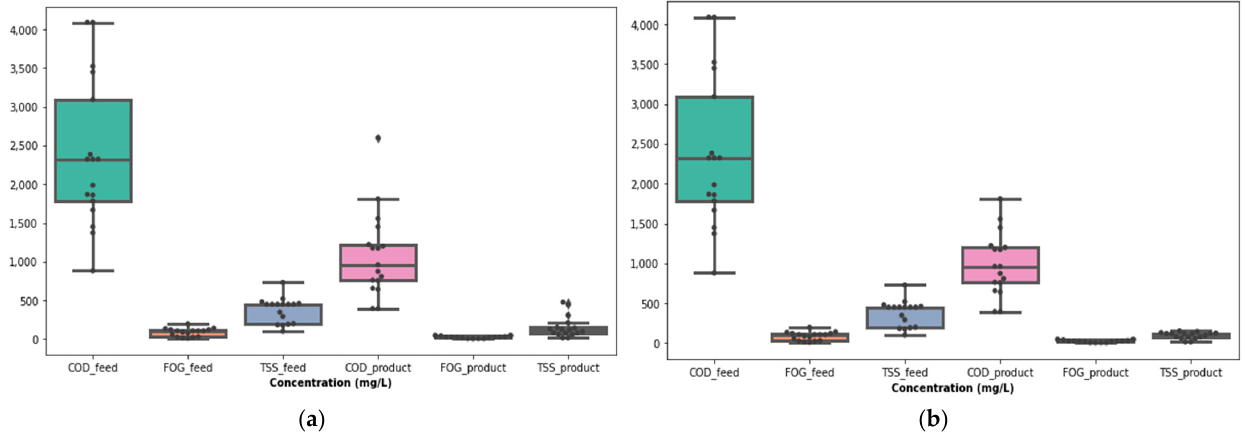
Figure 9. EGSB treatment parameters before and after anomaly detection. ( a ) Anomaly detection and correction. ( b ) After anomaly detection and correction.